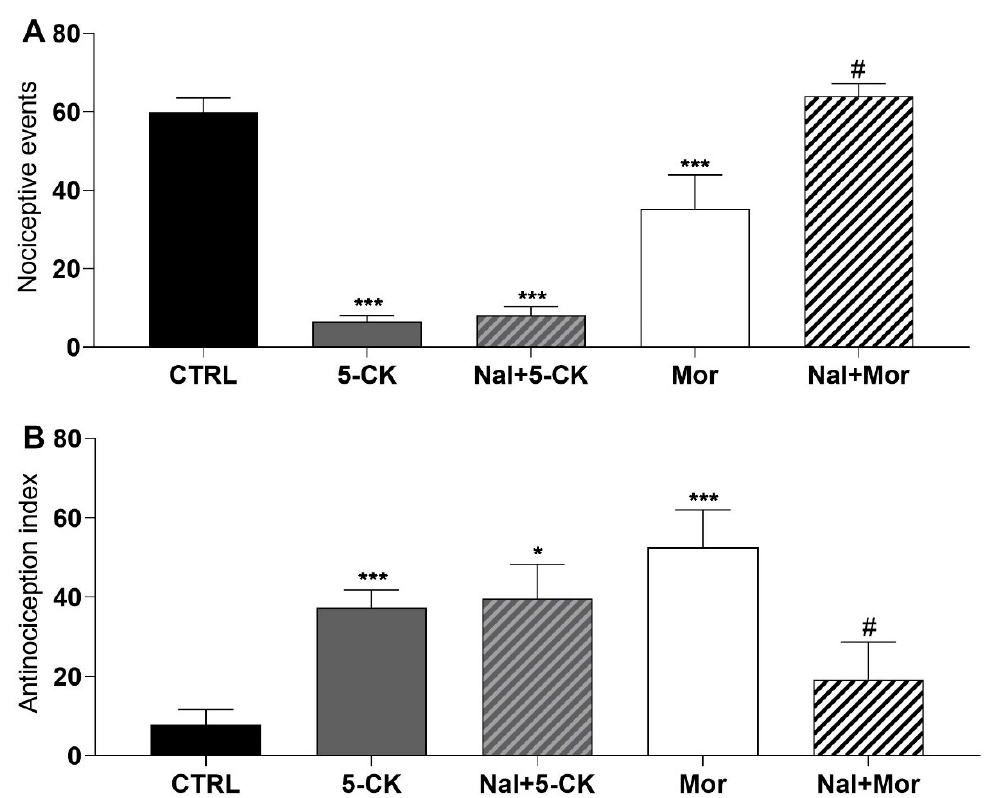
Figure 4. Effect of the pharmacological blockade of opioid receptors on the 5-CK-induced antinociception. Antagonism assays were performed on cold plate; and ( A ) tail flick; ( B ) tests with naloxone (Nal, 5 mg/Kg), a non-selective antagonist of opioid receptors. Naloxone was administered by intraperitoneal route (ip) 15 min before the administration of 5-CK (50 mg/Kg, ip) or morphine (Mor; 5 mg/Kg, ip). Data are expressed as means ± SEM; n = 6 mice per group. # Significantly different from Mor group ( p < 0.05) * Significantly different from the control group ( p < 0.05). *** Significantly different from the control group ( p < 0.001). One-way ANOVA followed by Tukey’s